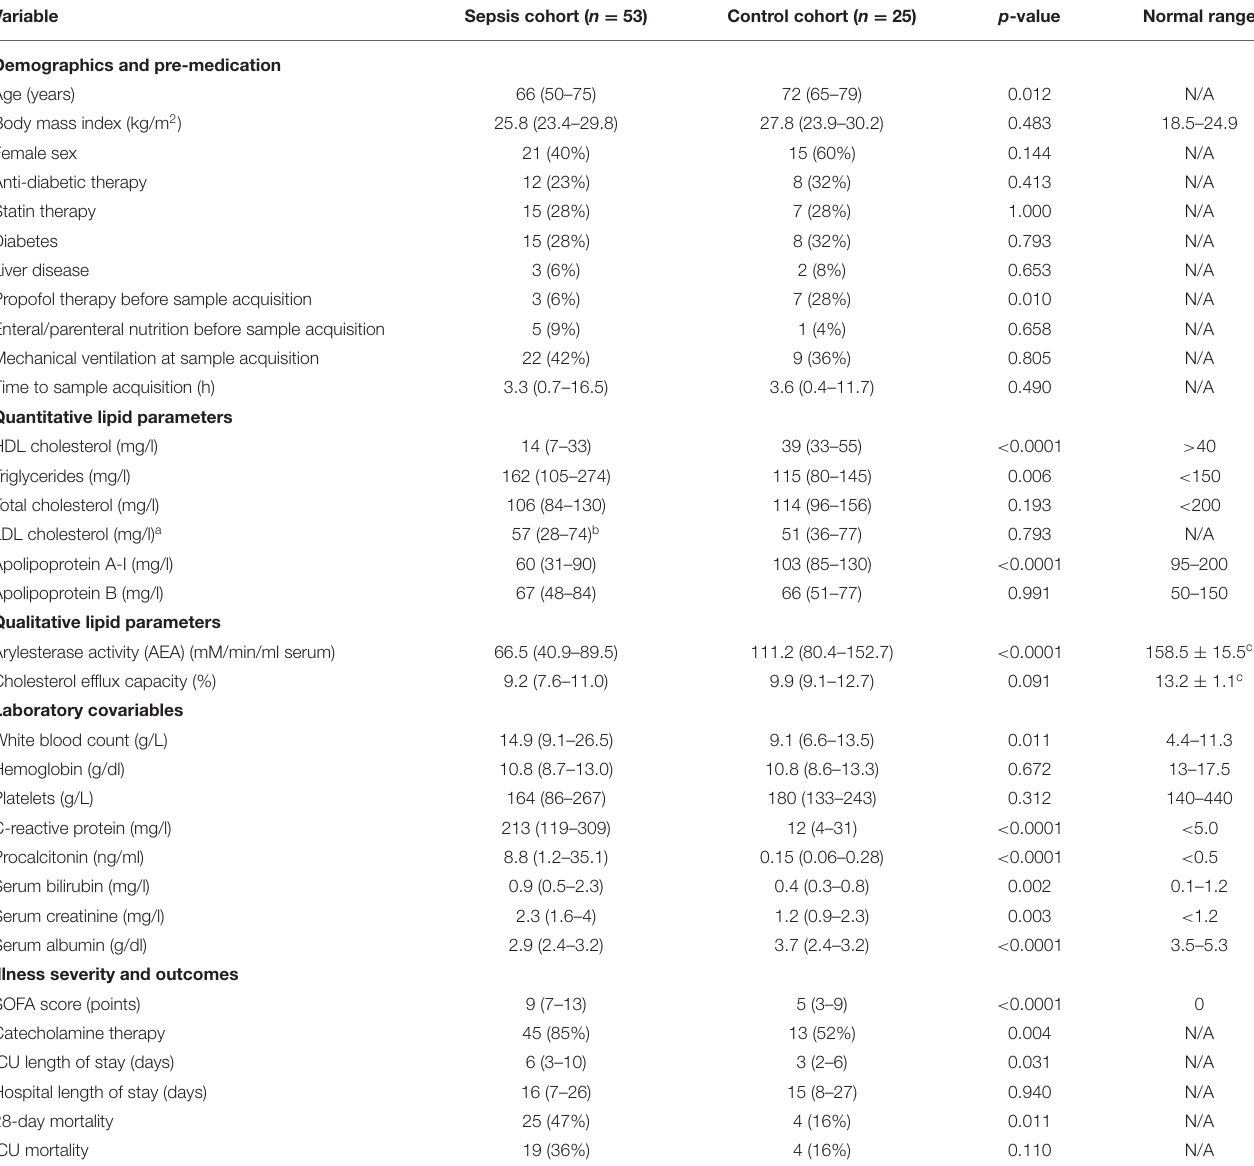
TABLE 1 | Baseline characteristics and outcomes of the study population. Variable Sepsis cohort ( n =